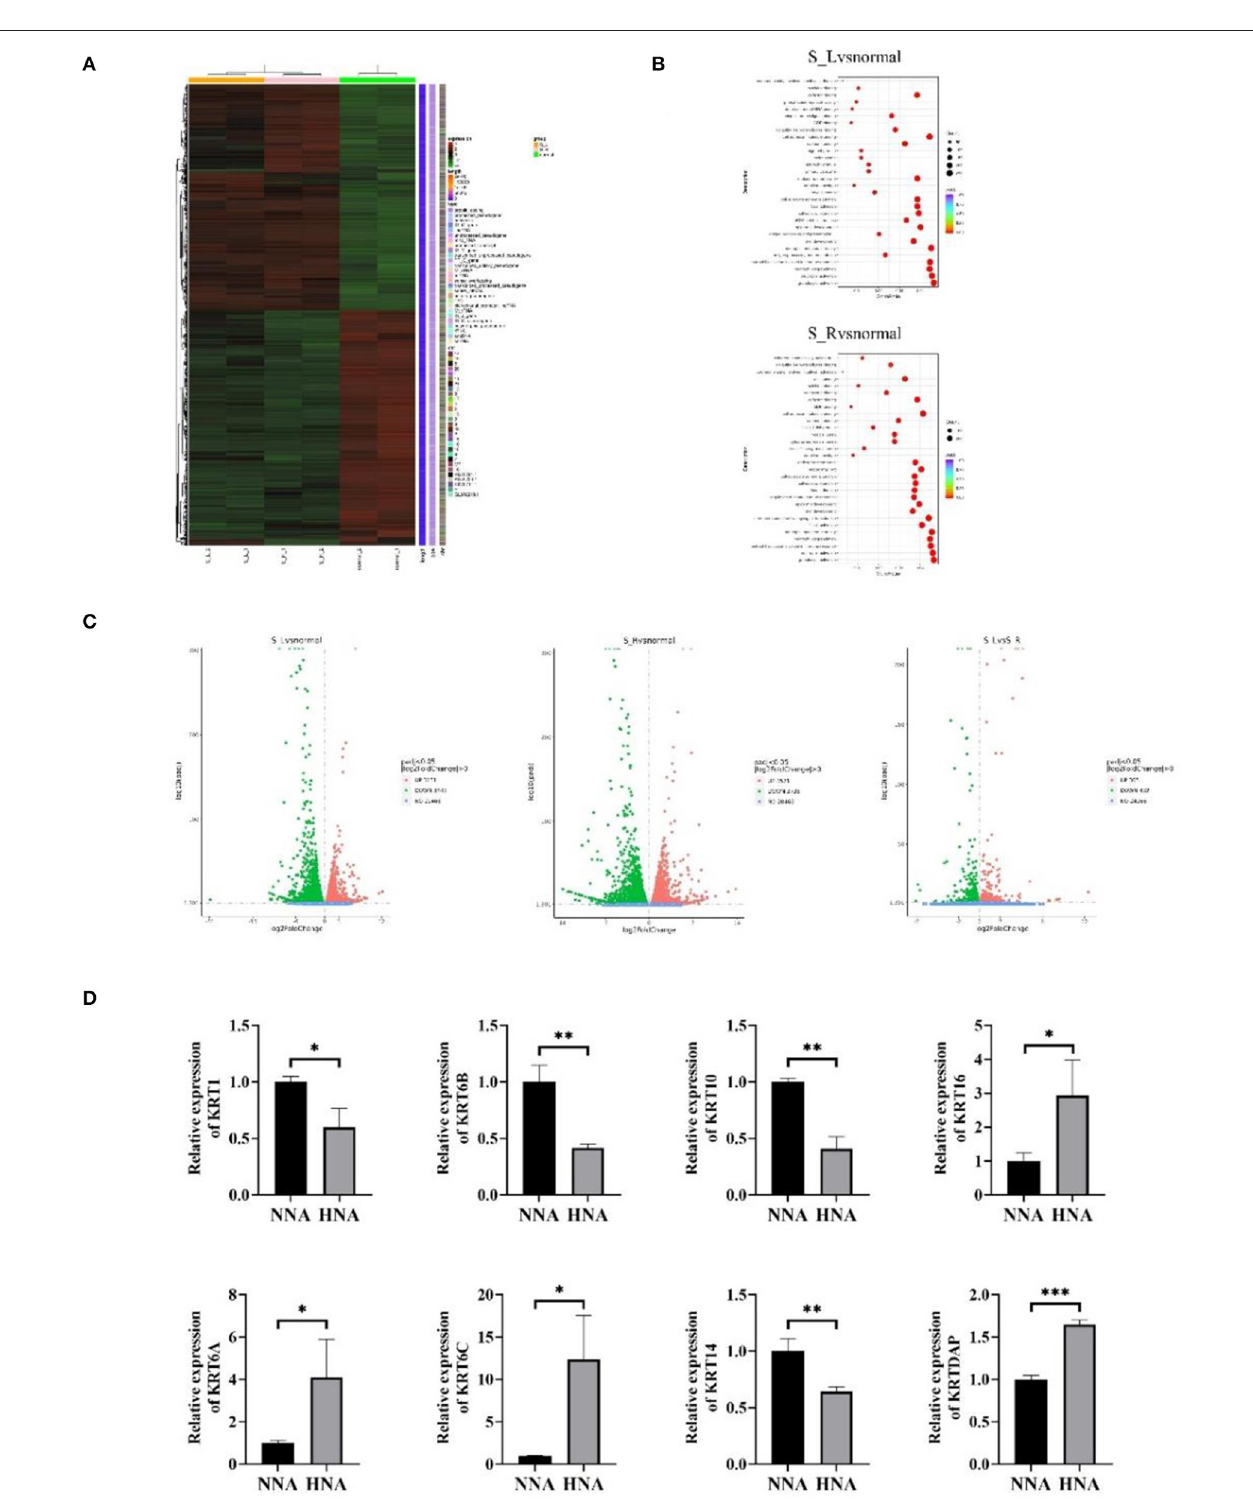
FIGURE 2 | Genomic expression detected by RNA-sequencing performed between the HNA and normal nipple and areola (NNA). (A) The heat map of the genomic expression cluster. Group S-L means the left mammary area. Group S-R means the right mammary area. Group normal means the mammary area from the normal patient. (B) The enrichment analysis aimed at detecting the variation of the cell signaling pathways and biological functions among different groups in the right and left mammary areas. (C) The gene expression of the lesions from both sides. The difference in gene expression between the lesions from both sides was not obvious, while the difference in gene expression between the lesions and healthy samples was obvious. (D) Keratins and their associated proteins are dysregulated in HNA compared to NNA. * P < 0.05, ** P < 0.01, *** P < 0.001.